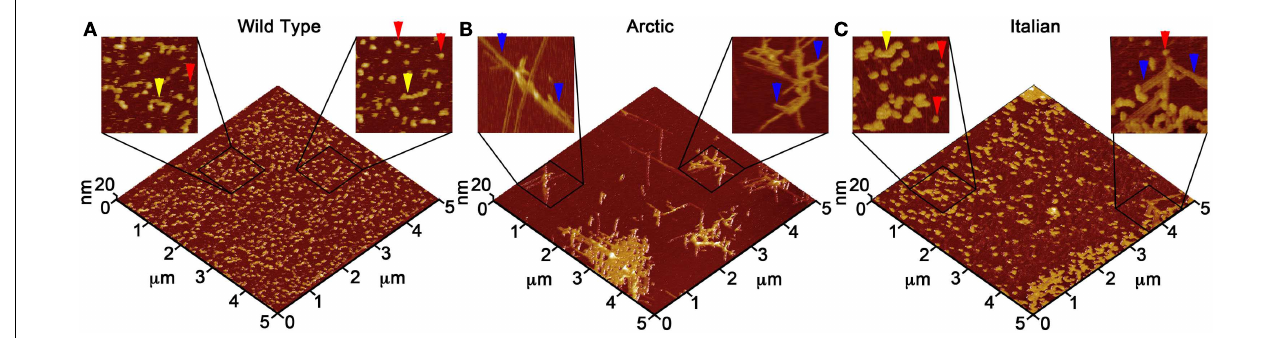
formed rigid, branched, and highly ordered fibrillar aggregates (blue arrows) along the crystallographic lattice of mica with aggregate heights of ∼ 2–5nm along the contour.These Arctic A β aggregates morphologically distinct from those formed byWildType A β . (C) Italian A β predominately aggregated into small oligomers (2–3nm tall, red arrows) that coalesced into larger protofibrils (yellow arrows), in a similar fashion toWildType A β ; however, a small number of rigid, elongated “Arctic-like” fibrillar aggregates of Italian A β also formed (blue